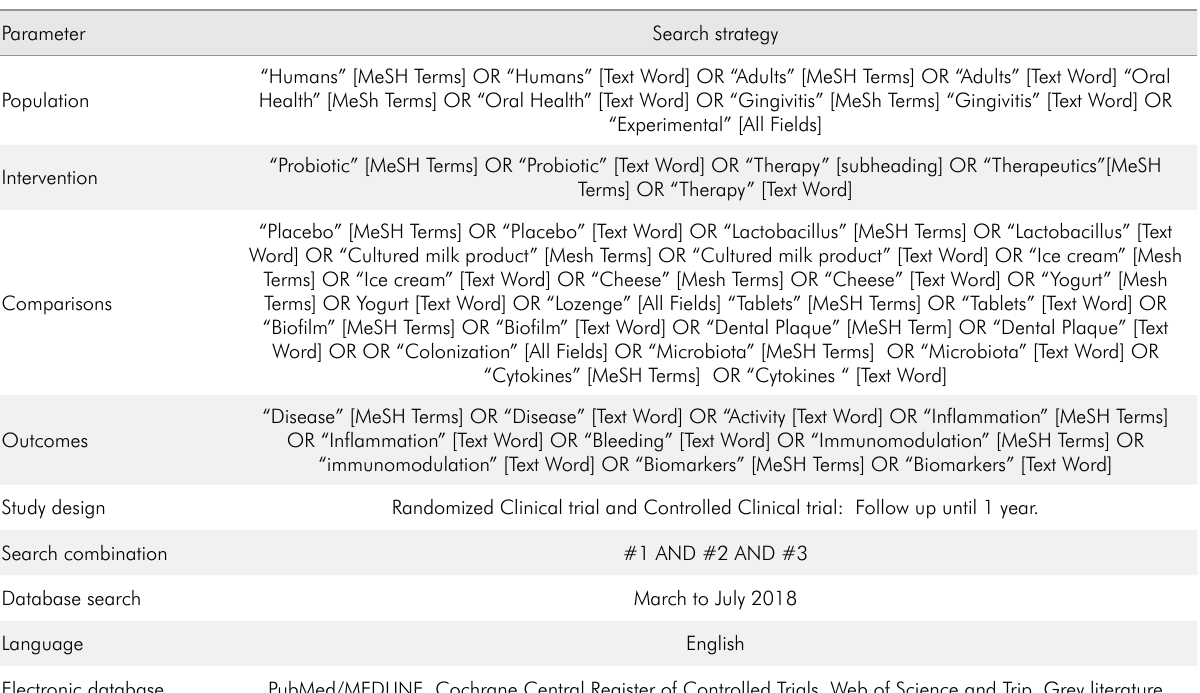
Table 1. Systematic search strategy